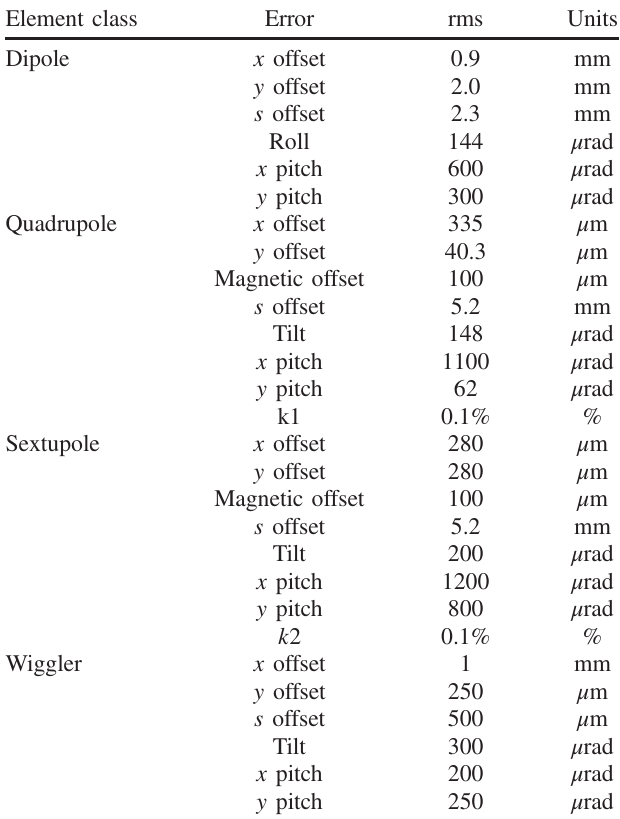
TABLE VIII. Misalignments and errors introduced into model CesrTA lattice for RING _ MA 2 studies. All parameters are determined either from machine measurements or survey.